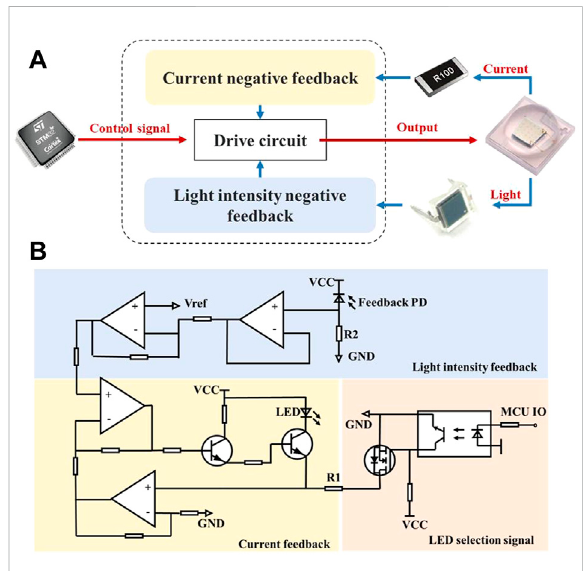
FIGURE 4 Thecurrent-lightdualnegativefeedbackLEDdrivecircuit. (A) Working schematic block diagram of the circuit, the current-light dual negative feedback is realized by sampling the current and the light intensity of the LED. (B) Schematic of the circuit which can be divided into three partitions of current feedback, light intensity feedback and LED